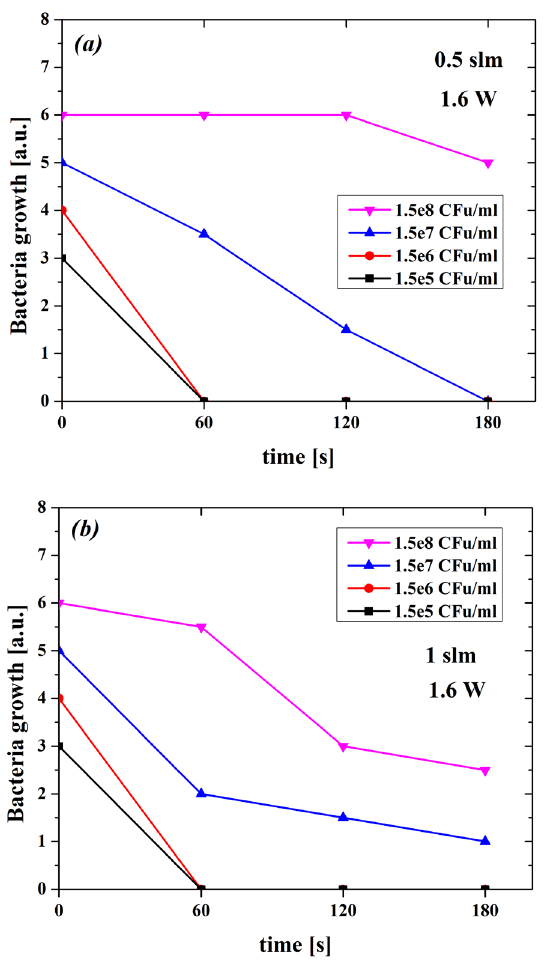
Figure 5: Sterilization of Pseudomonas aeruginosa ATCC 27853. The samples contained four different concentrations of bacteria. Treatment power was 1.6 W. (a) He flow 0.5 sLm; (b) He flow 1 sLm. Values for 0 s correspond to the values of positive untreated